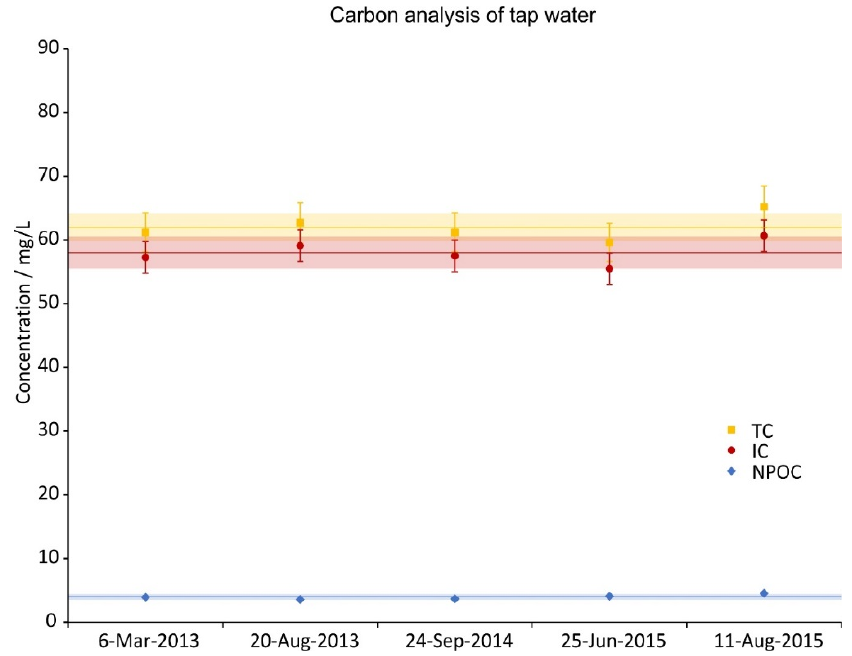
Figure 6. Total carbon (TC), inorganic carbon (IC) and non-purgable organic carbon (NPOC) concentrations of 5 random tap water samples during the investigation period. IC was calculated from as difference of TC and NPOC. The error bars show the precision of the measurement (5%), the lines are the averages and the shaded regions depict the standard deviations over the 5 samples.